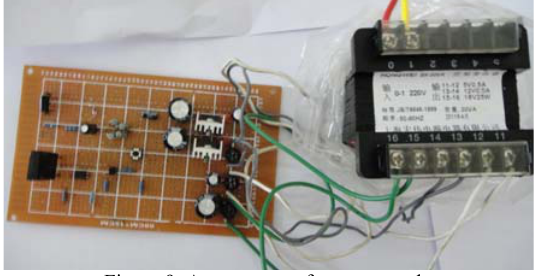
Figure 9. A prototype of power